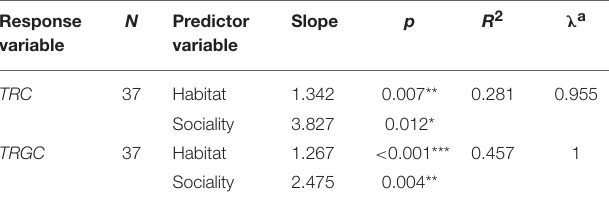
TABLE 2-2 | Significant results of PGLS multivariate regression for TRC gene numbers vs. ecological factors. Response